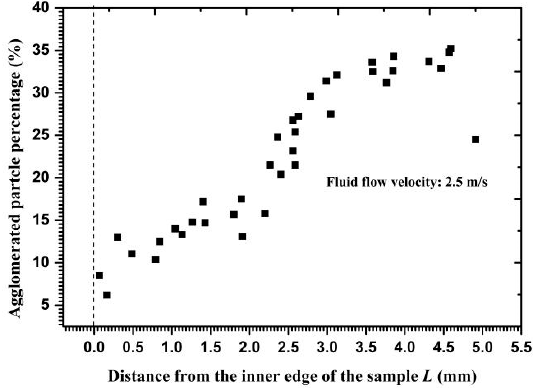
Figure 14. Clustered particle percentage versus the distance from the inner edge.